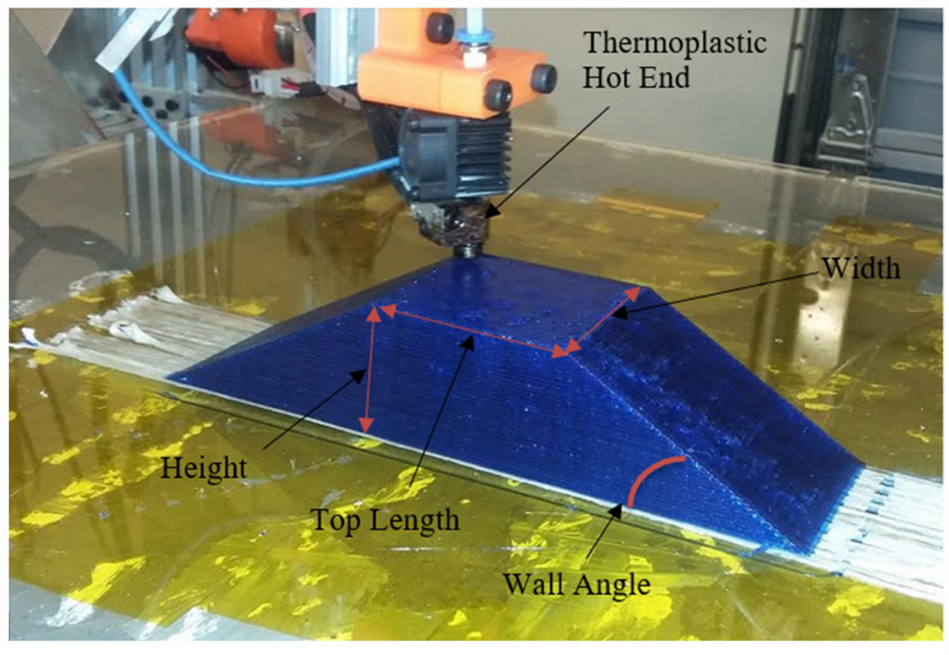
Figure 4. 30 ◦ trapezoid tool